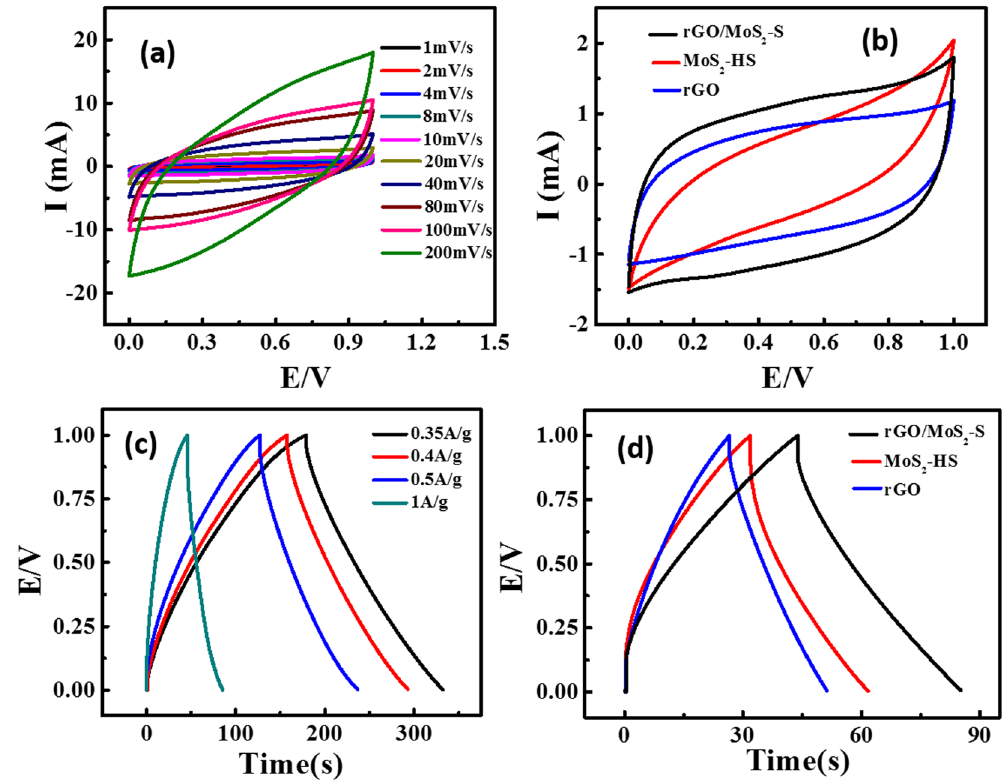
Figure 6. ( a ) CV of rGO/MoS 2 -S hybrid at different scan rate (1 to 200 mV/s), ( b ) CV of MoS 2 -HS, rGO and rGO/MoS 2 -S hybrid at 10 mV/s, ( c ) GCD data of rGO/MoS 2 -S hybrid at different current density and ( d ) GCD of MoS 2 -HS, rGO and rGO/MoS 2 -S hybrid at a current density of 1